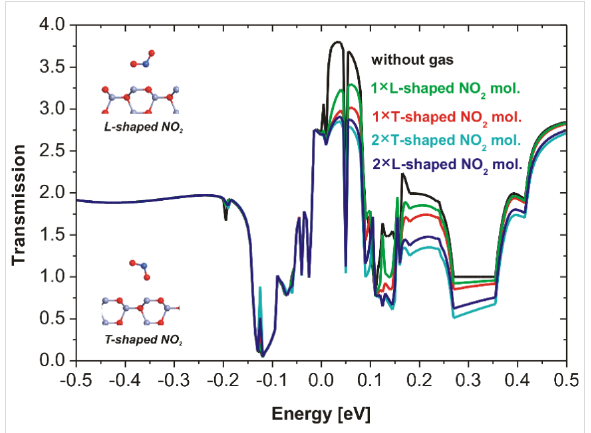
Figure 5: Transmission spectra of the hybrid ZnO/NCD structure with- out and with one or two NO 2 molecules at two different orientation. Zero energy is the Fermi level. Transmission values determining the conductivity (resistivity) measured at 150 °C are within the range of 0–0.15